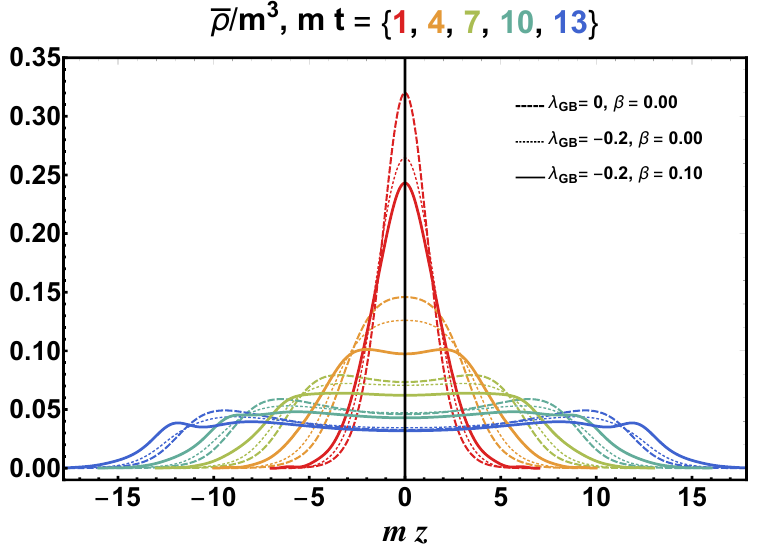
Figure 3 . Time evolution of the baryon number density after the collision of thick sheets with (cid:15) = 0, as in (cid:12)gure 1. Colors denote snapshots in time. Solid/thin-dashed/thick-dashed curves denote di(cid:11)erent values of (cid:21) and (cid:12) . GB